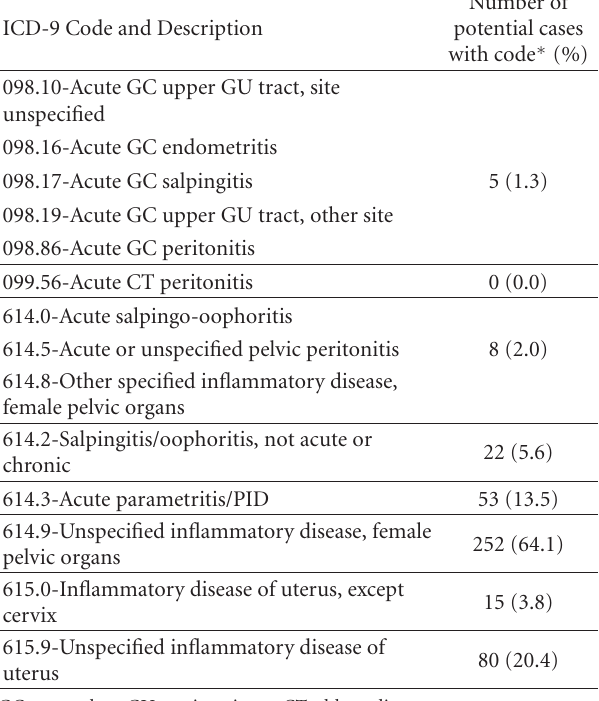
Table 1: ICD-9 codes commonly utilized to identify possible acute pelvic inflammatory disease (PID) and code distribution among potential PID cases sampled from Group Health